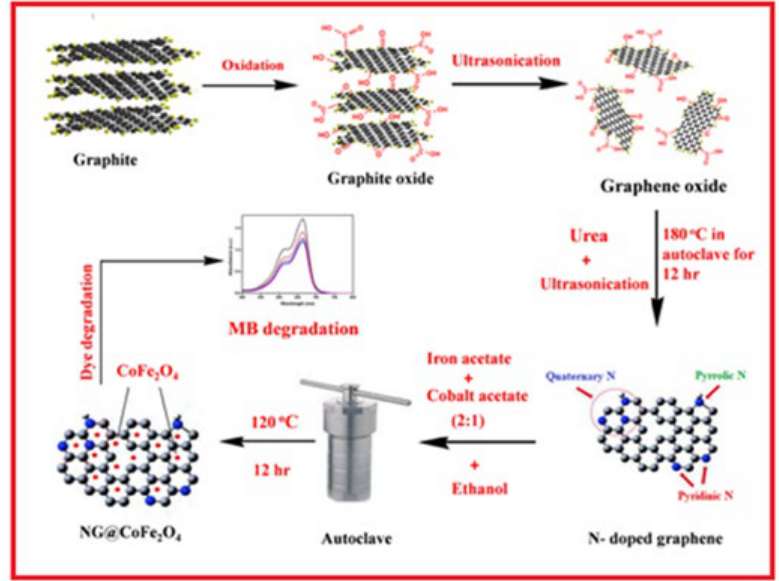
Fig. 1: Schematic representation of the synthetic Fig. 1 Schematic representation of the synthetic procedure.